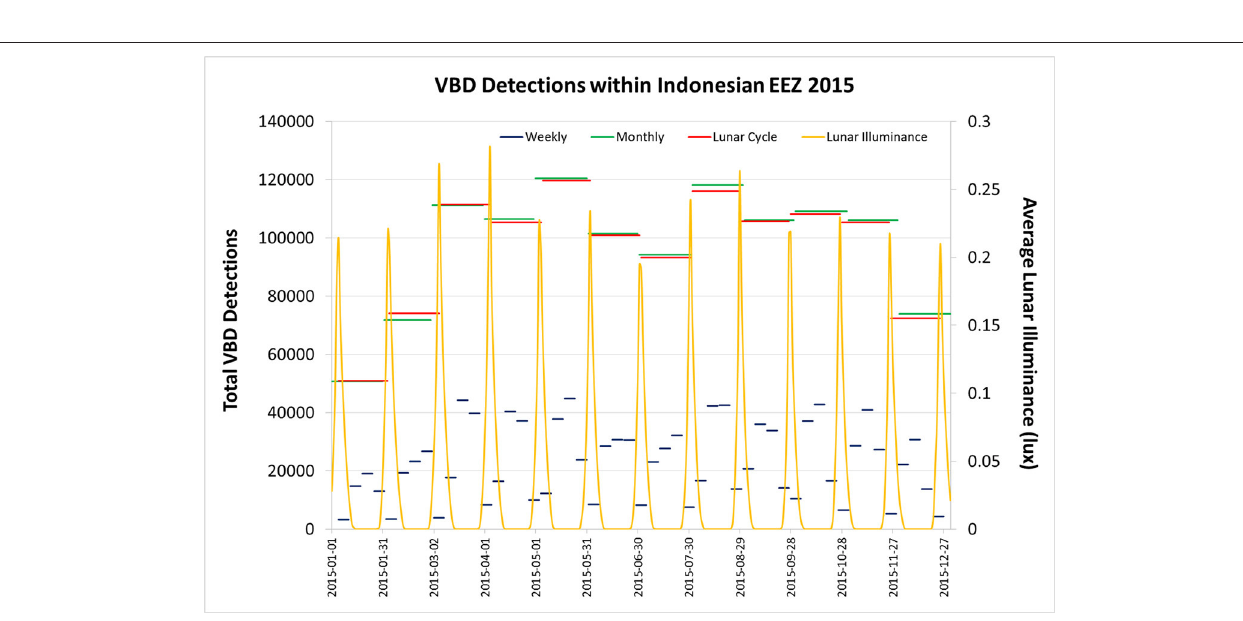
FIGURE 4 | Results from three styles of temporal aggregation of the nightly VBD data shown in Figure 3 : weekly, monthly, and lunar cycle. The weekly aggregation is calculated from Monday through Sunday. The lunar cycle aggregation is calculated from full moon to full moon.